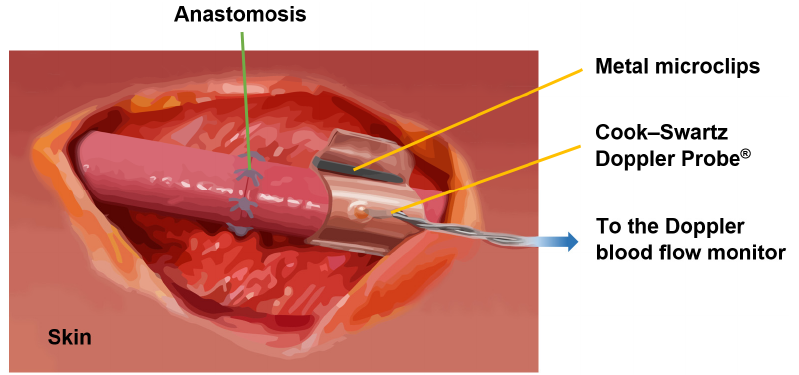
Figure 18. Illustration of the use of the Cook–Swartz Doppler Probe ® in the monitoring of blood flow after a vascular anastomosis of free